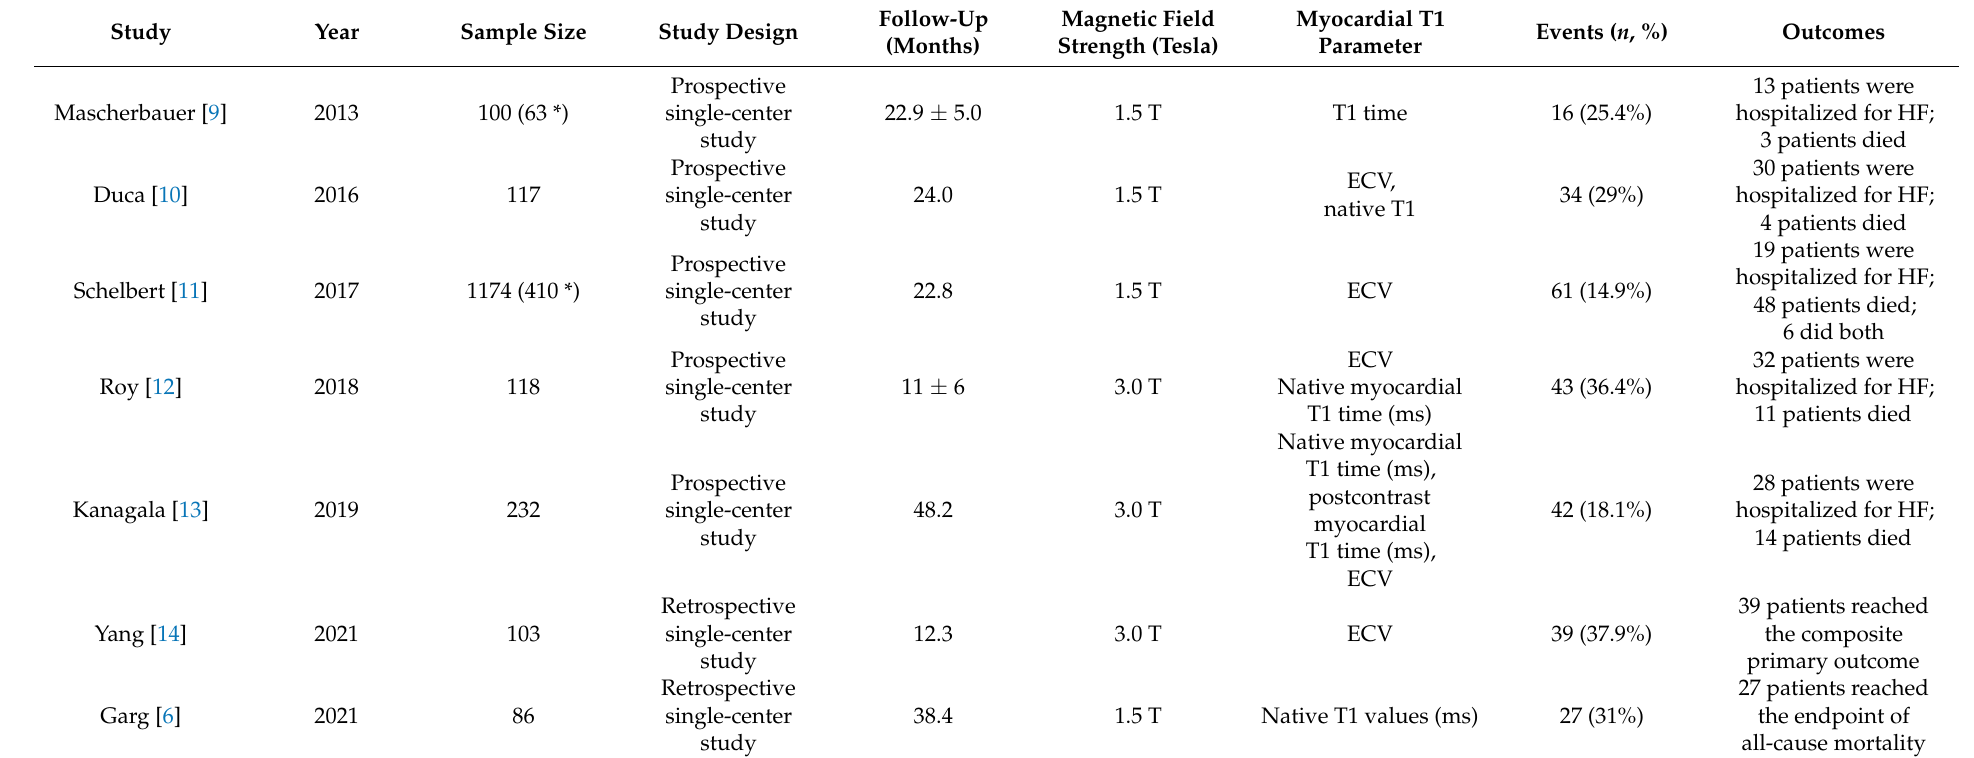
Table 1. Baseline characteristics of studies included in the